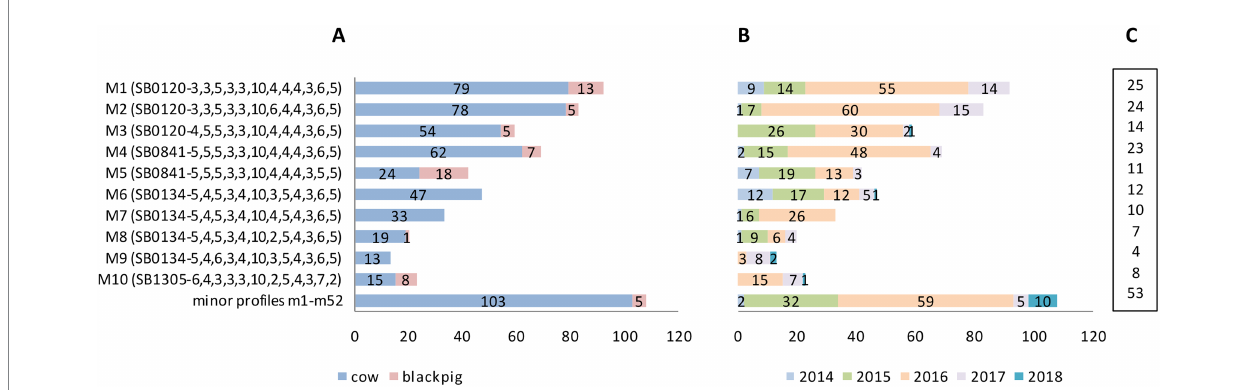
FIGURE 5 Mycobacterium bovis genetic profiles by host, year of isolation and number of infected farms. (A) The top 10 most frequently isolated profiles (major profiles M1–M10) and the group of less frequent, minor profiles (m1–m52, further details in Supplementary Table S1 and section 3.3.2) by host: number of isolates from cattle in blue, black pigs in pink. (B) Genetic profiles by year of isolation (number of isolates). (C) Genetic profiles by number of TB infected